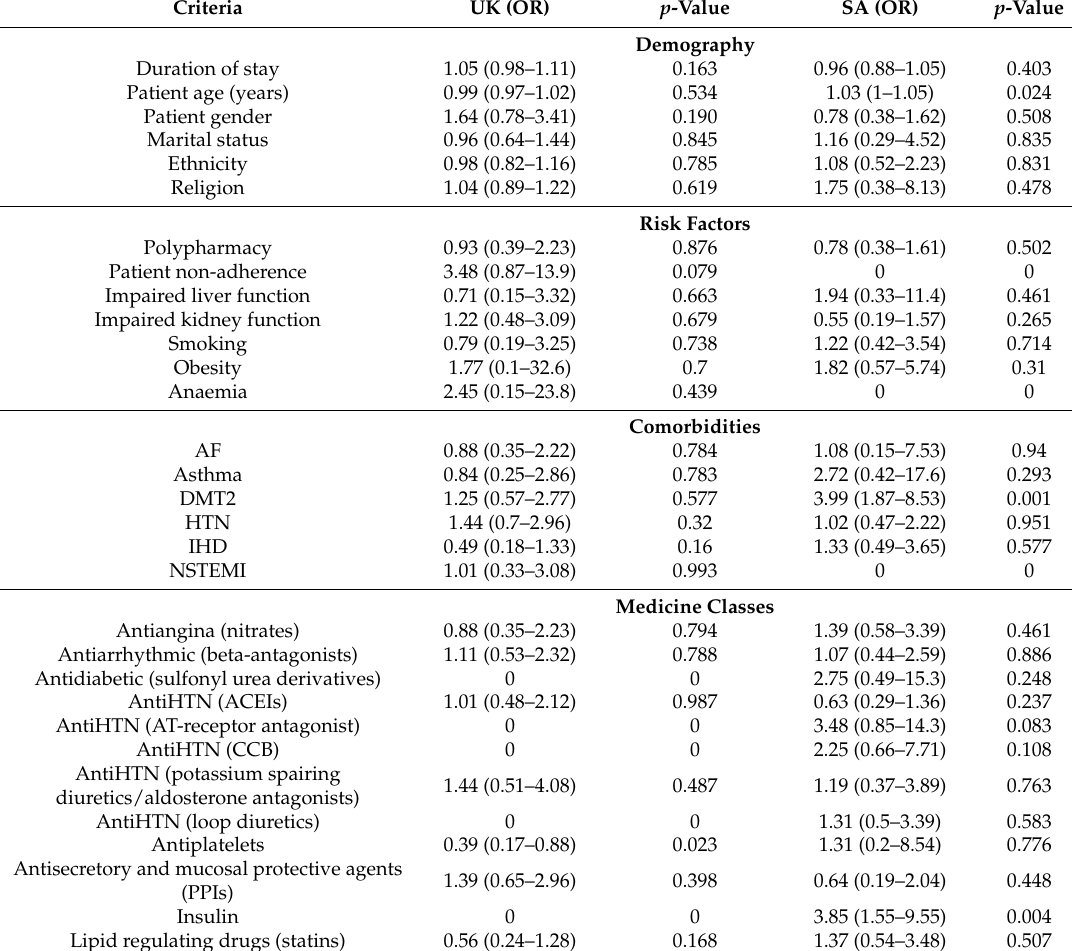
Table 2. Potential predictors for MRP occurrence in both